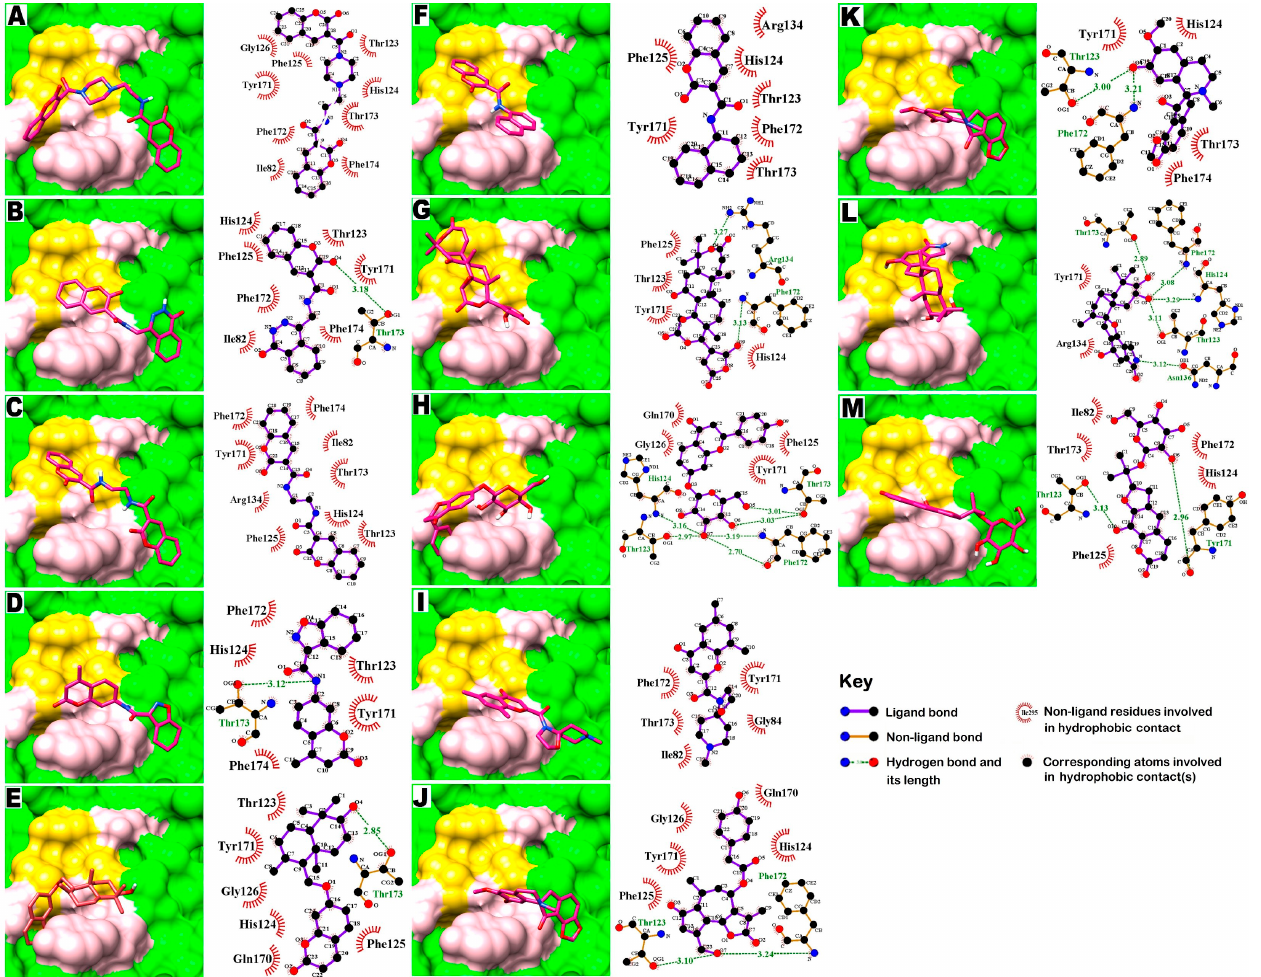
Figure 6. Molecular surface representation of EBOV-Z VP40 with respective ligands. ( A – M ) Molecular surface representation (in green) with respective ligands displayed in stick format (in magenta). Binding site residues are in pink. Residues Thr123, Phe125, and Arg134 form the catalytic triad in the active sites that interact with RNA are displayed in yellow. Alongside each 3D complex are schematic representations of the 2D interactions (with a cutoff distance of 4 Å) between each ligand and EBOV-Z VP40 amino acid residue using Ligplot analysis. Residues involved in hydrophobic contacts are black and demarcated by a spoked red arc, while those involved in hydrogen bonding are green, along with the values of the distances. Atoms are shown in black for carbon, red for oxygen, and blue for nitrogen.